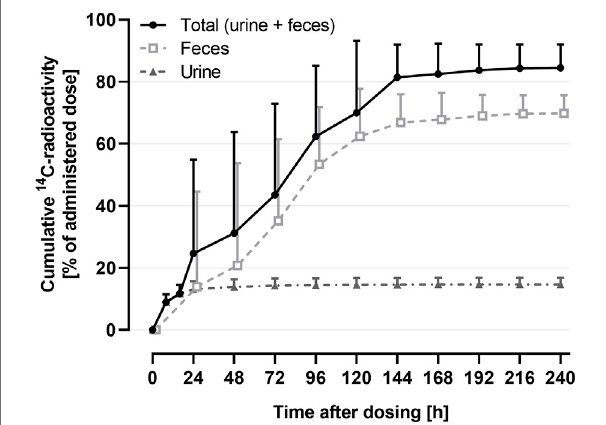
FIGURE3| Arithmeticmean(+SD)cumulativerecoveryvs.timepro fi leof total 14 C-radioactivity in urine and feces (shown as % of administered